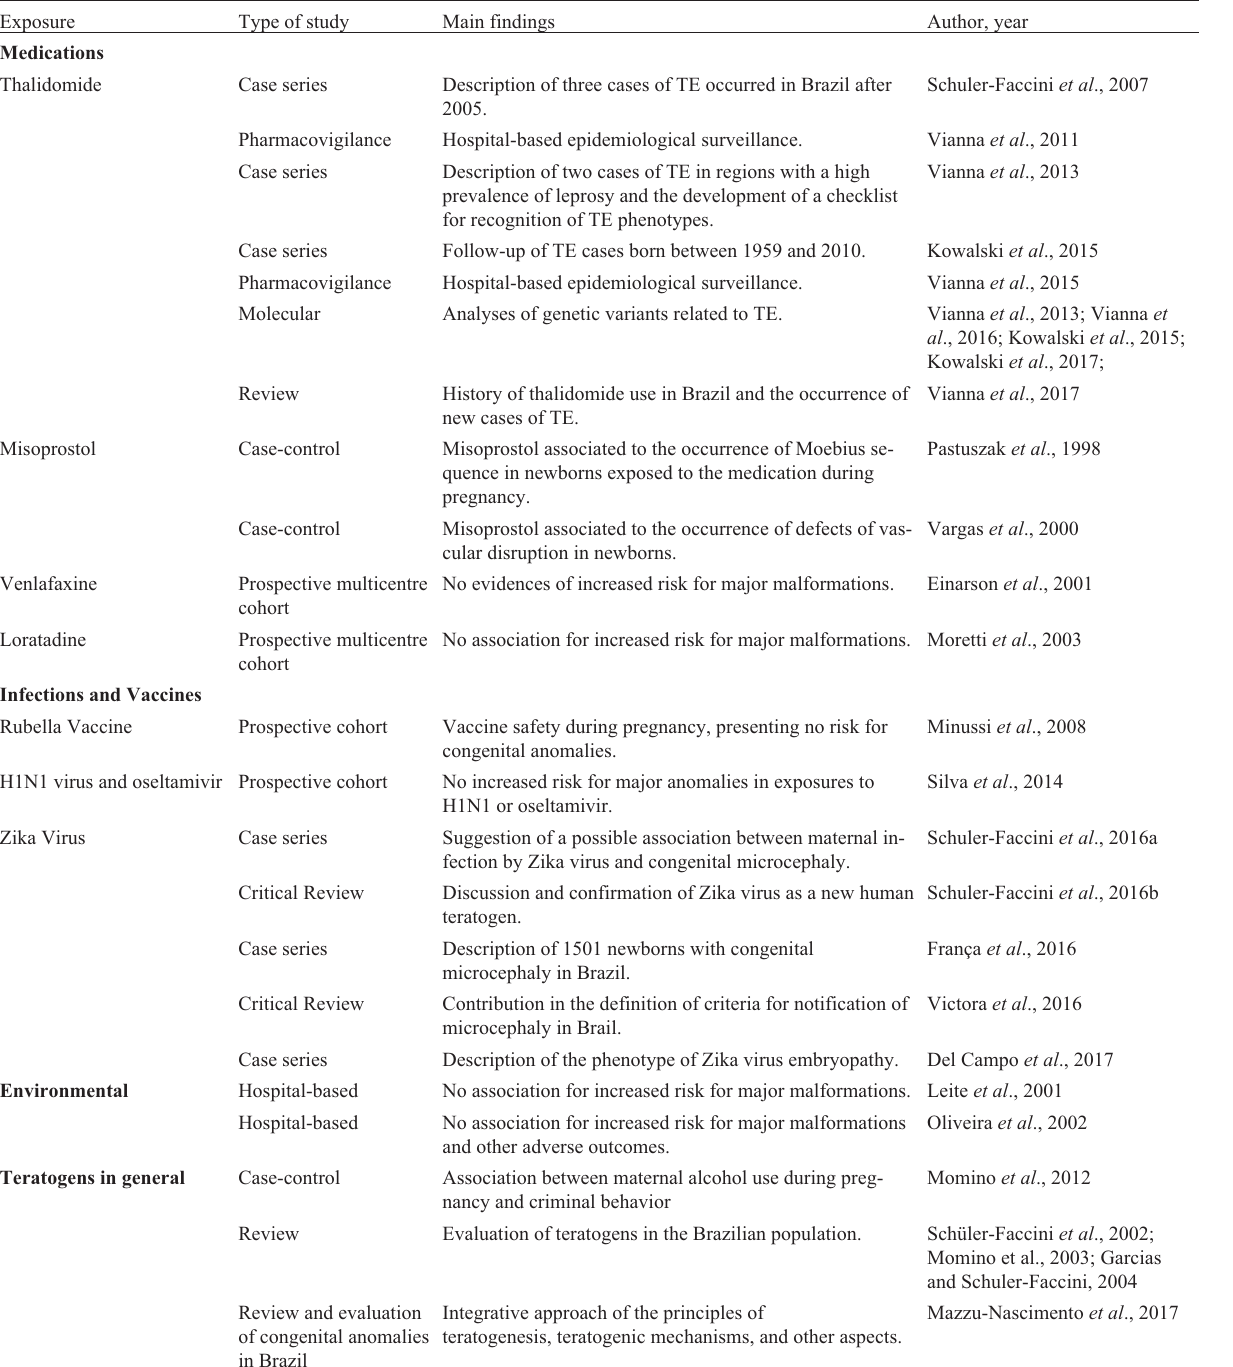
Table 4 - Selected SIAT studies and its contribution to the field of human teratogenesis.